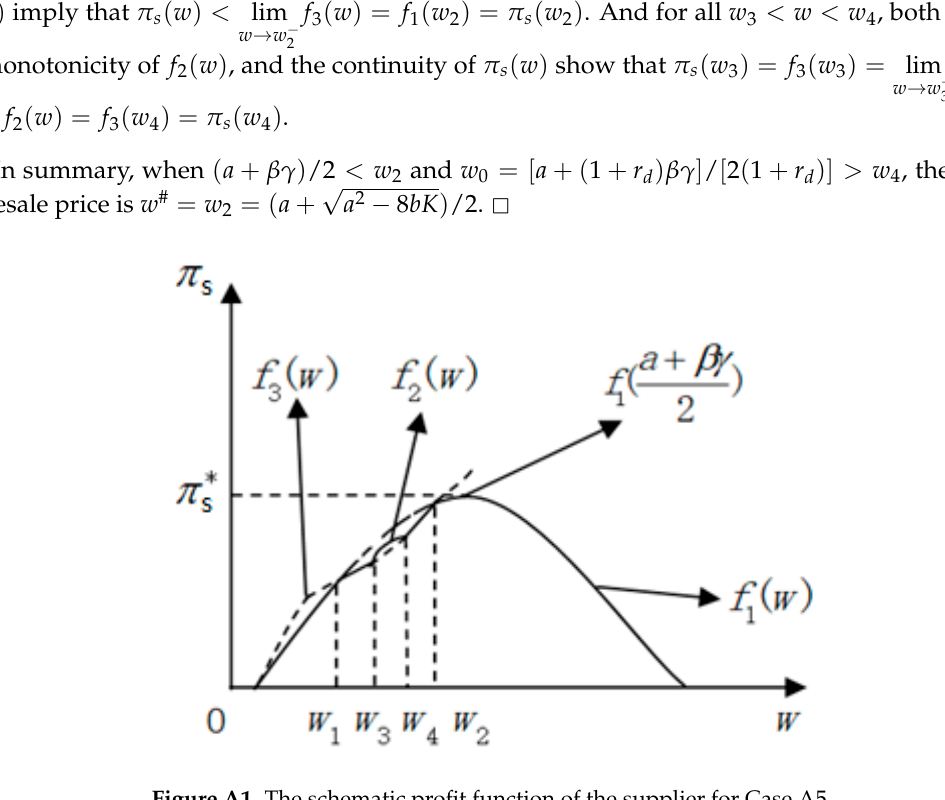
Figure A3. The schematic profit function of the supplier for Case A7.